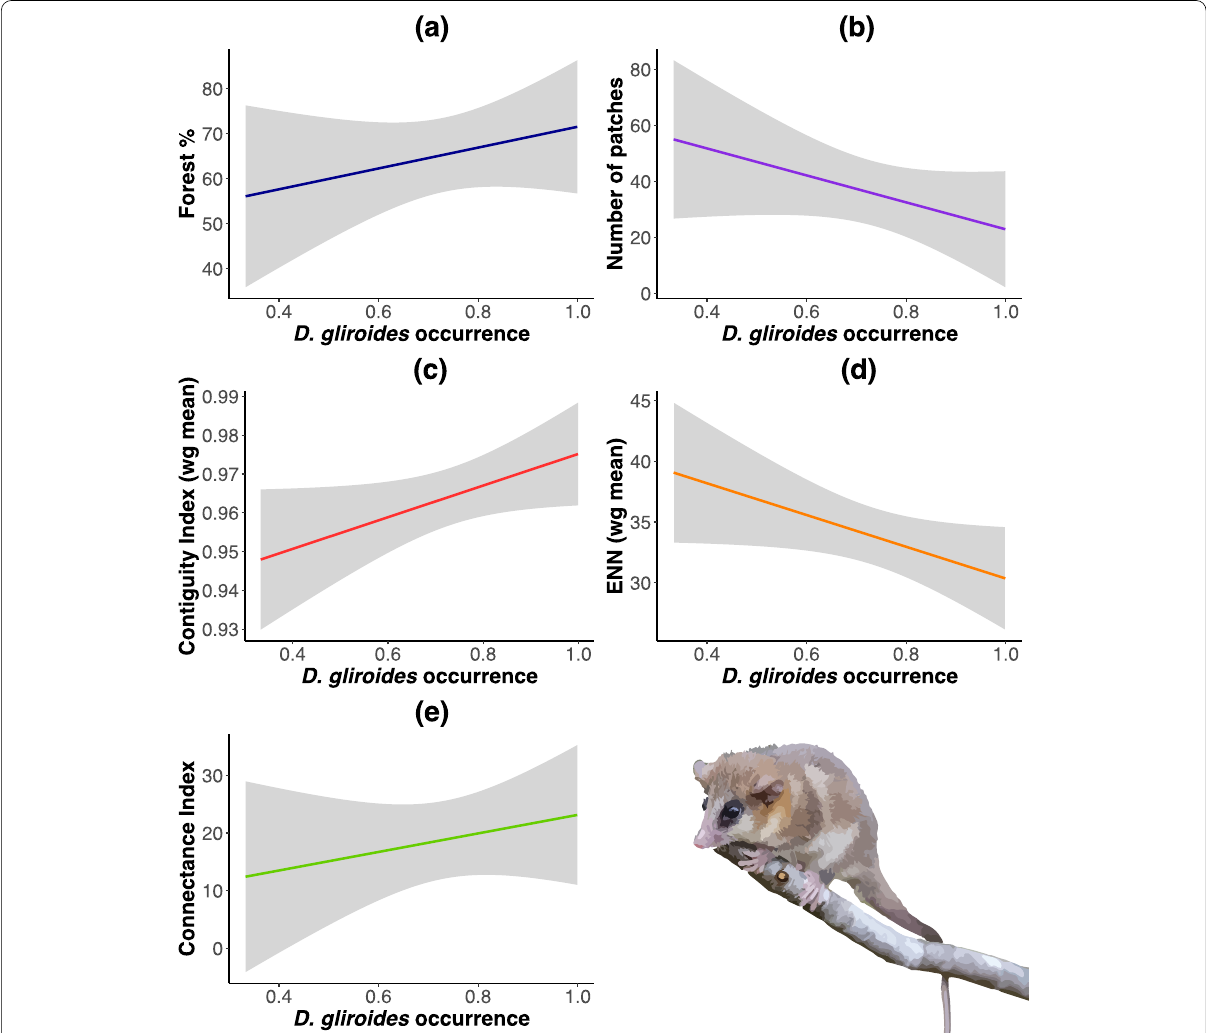
Fig. 2 Linear relationships of landscape metrics and Dromiciops gliroides occurrence. Landscape metrics used: ( a ) proportion of forest cover in the landscape (PLAND), ( b ) number of patches (NP), ( c ) contiguity index (CONTIG, weighted mean), ( d ) Euclidean distance to the nearest neighbor (ENN, weighted mean), and ( e ) connectivity index (CONNECT, measured at 250 m). Shaded areas represent 95% confidence